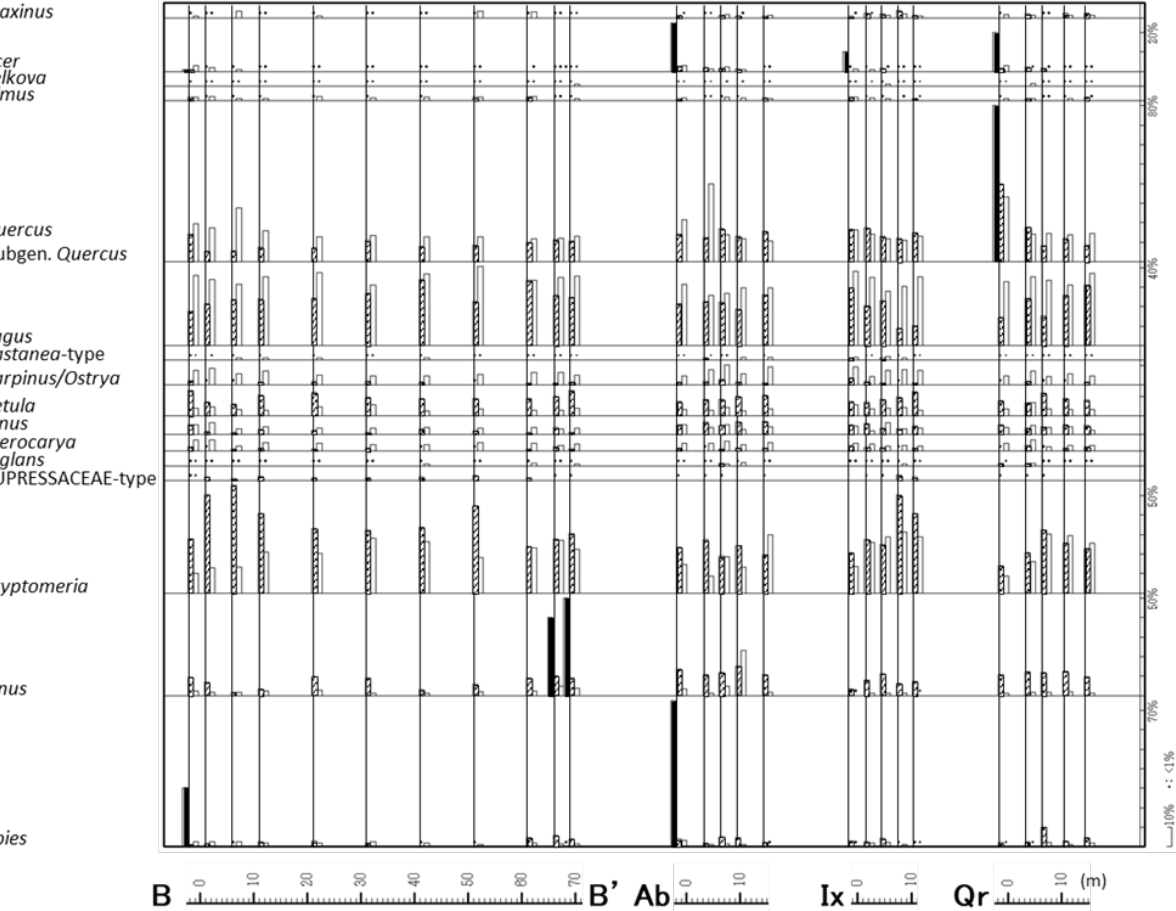
Figure 3. Diagram comparing percent coverage of plants (solid), surface pollen percentages (hatched) and pollen percentages in 915 CE (open) of selected trees on Lines B, Ab, Ix and Qr. Pollen percentages are expressed as a proportion of the total tree pollen count. Plus signs in the diagram indicate abundances < 1.0